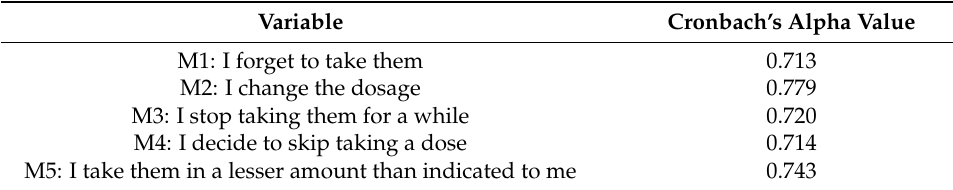
Table 5. Internal consistency of the